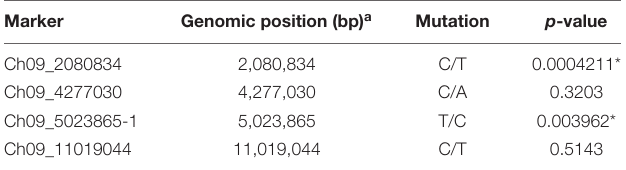
TABLE 2 | Chromosomal position and Kruskal–Wallis test p -values of four SNP markers tested for association with PRSV-W resistance in the F 2 population between Nigerian Local and Butterbush.